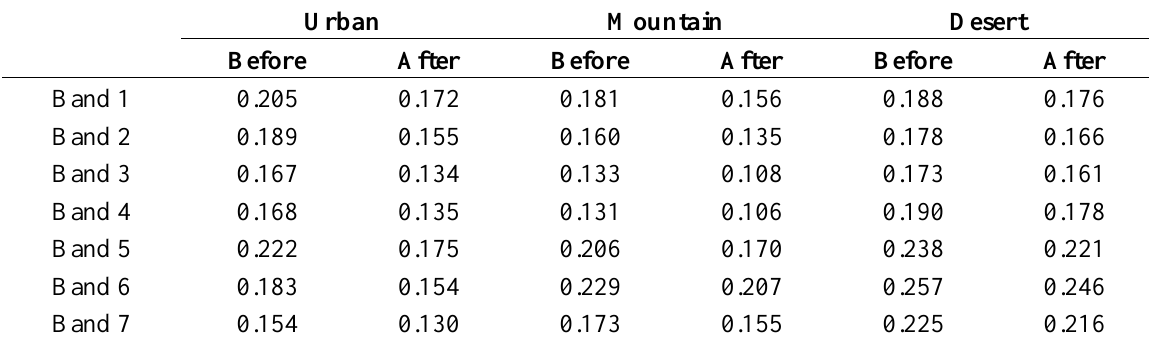
Table 4. Mean values of three subimages before and after the